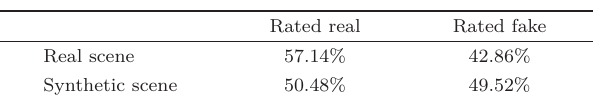
Fig. 10 Ablation study for source mask. Each row shows a scene with our shadow synthesis result and the result without source mask, m s . Table 4 User study